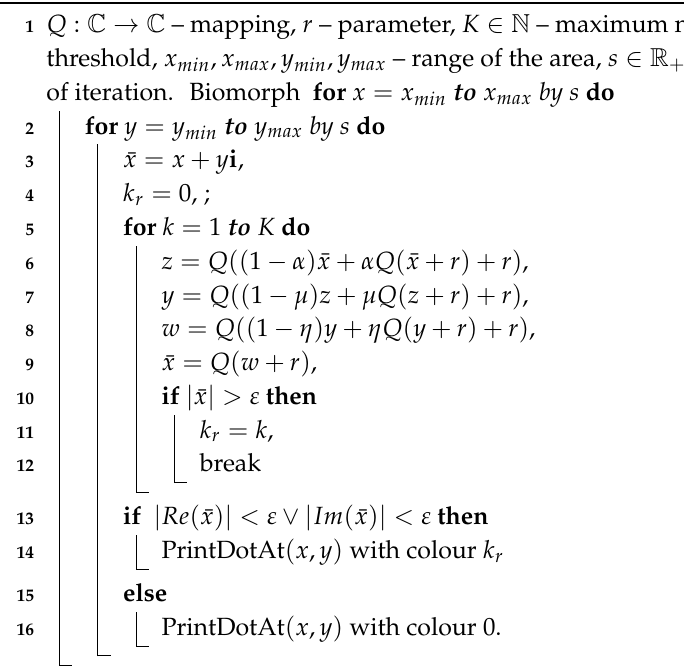
Algorithm 1: Biomorph generation.